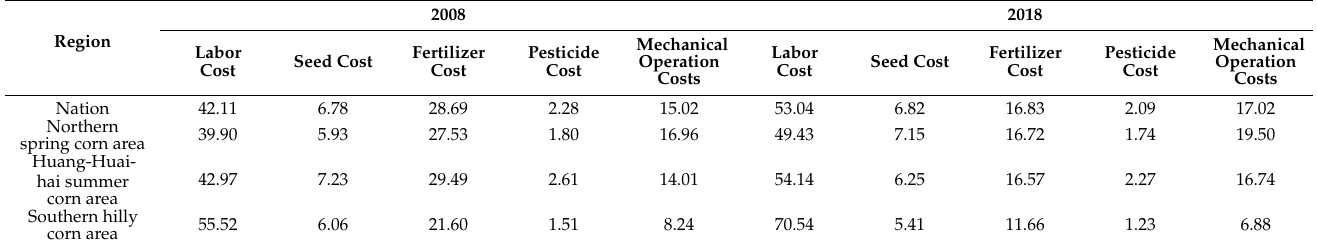
Table 2. Proportion of input of production factors